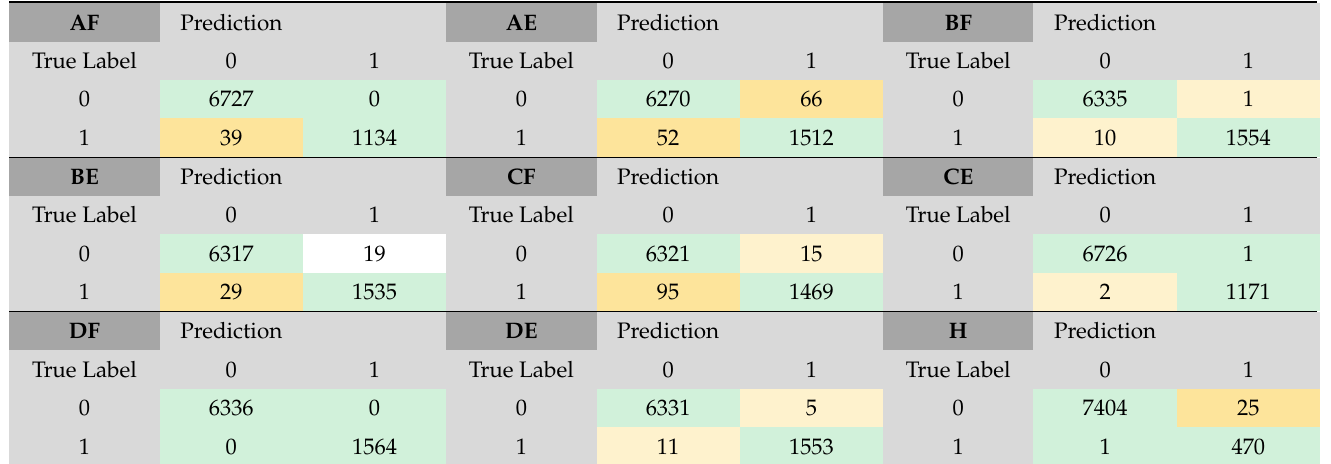
Table 5. Confusion matrices for the LSTM-based fault